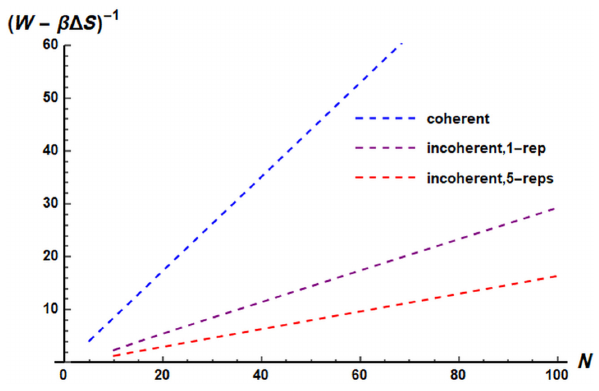
FIG. 4. Imperfect cooling with coherent and incoherent con- trol. We compare the performance of coherent and incoherent control protocols for cooling a degenerate qubit target by swap- ping it with machine qubits with linearly increasing energy. The final ground-state population is fixed to be 0.99. The inverse of the surplus work cost W − β (cid:4) (cid:5) S S (with β = 1) is plotted (in units ) against the total num- of the smallest machine energy gap, ω min M ber of unitary operations, with the temperature of the hot bath in the incoherent control protocols set to β H = ∞ in order to make meaningful comparison to the coherent control case. We see that the coherent control protocol (blue) outperforms the two incoher- ent ones (purple, red) at any given time. As discussed in the text, there are two choices for how to implement an incoherent control protocol of this type with fixed control complexity: The red line corresponds to a protocol in which a machine (subspace) with the same energy gap is reused 5 times before moving on to the next; on the other hand, the purple line depicts the case where there are no repetitions within each stage defined by a distinct energy gap in the machine. By inspection, the single-use incoherent protocol (purple) requires approximately 3 times more unitaries to achieve the same efficiency as the coherent one (blue), whereas the five- repetition incoherent protocol (red) requires approximately